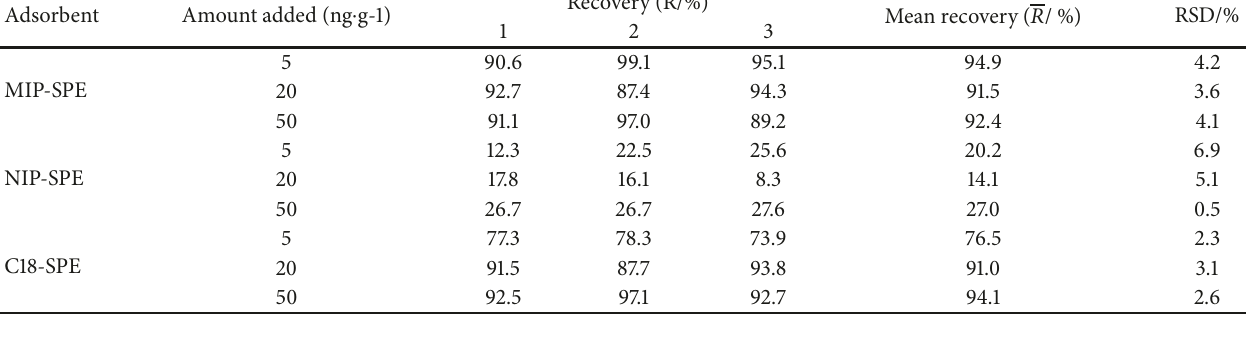
Table 4: Standard addition of ampicillin and relative standard deviations of ampicillin recovery from egg samples. Adsorbent